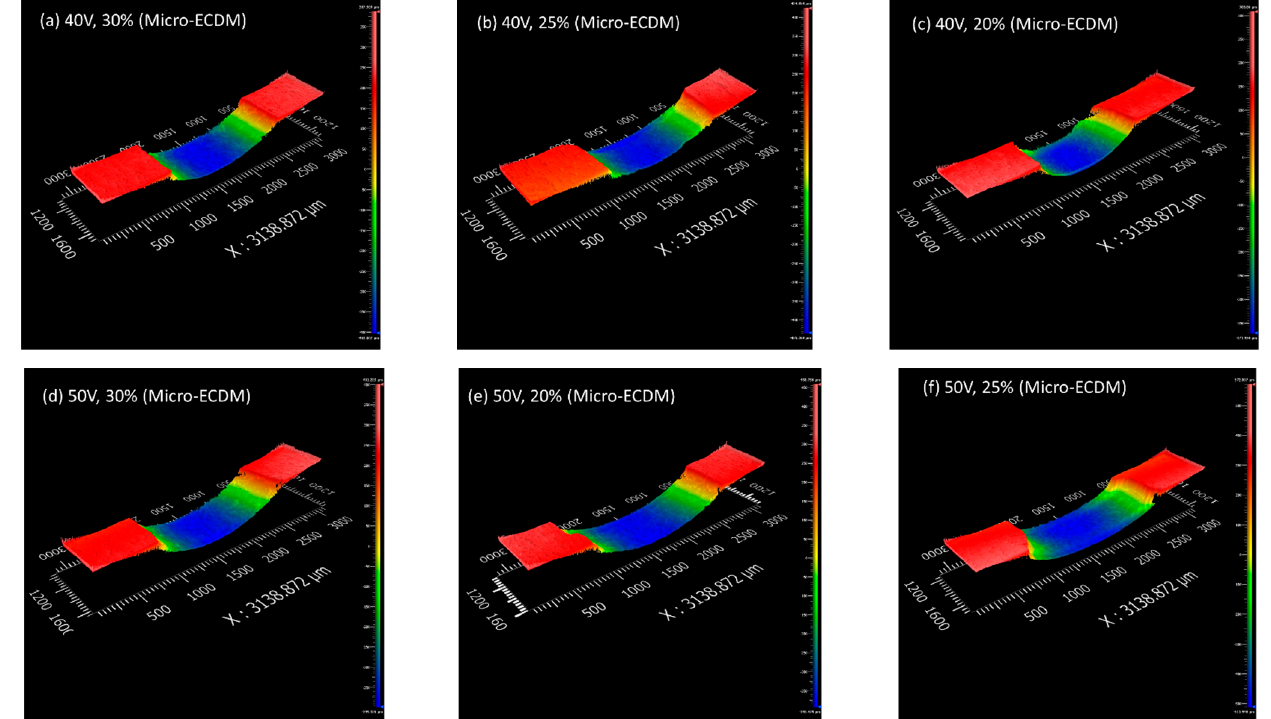
Figure 5. Three-dimensional surface profiles of the holes prepared using MECDM.